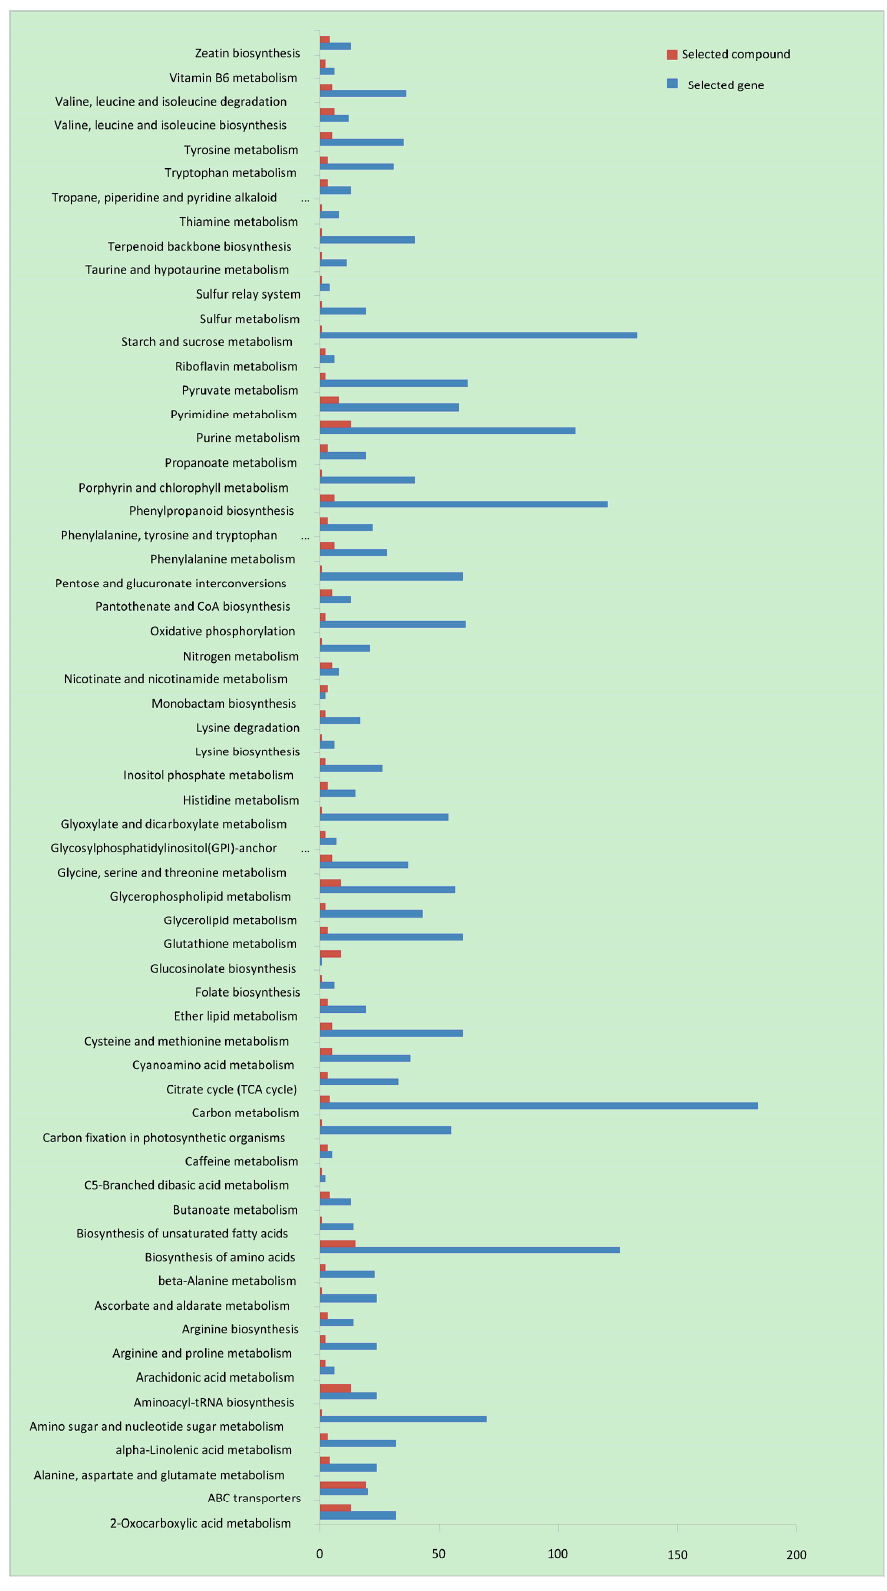
Figure 4. KEEG classification of DEGs associated with DEMs between A. correntina and